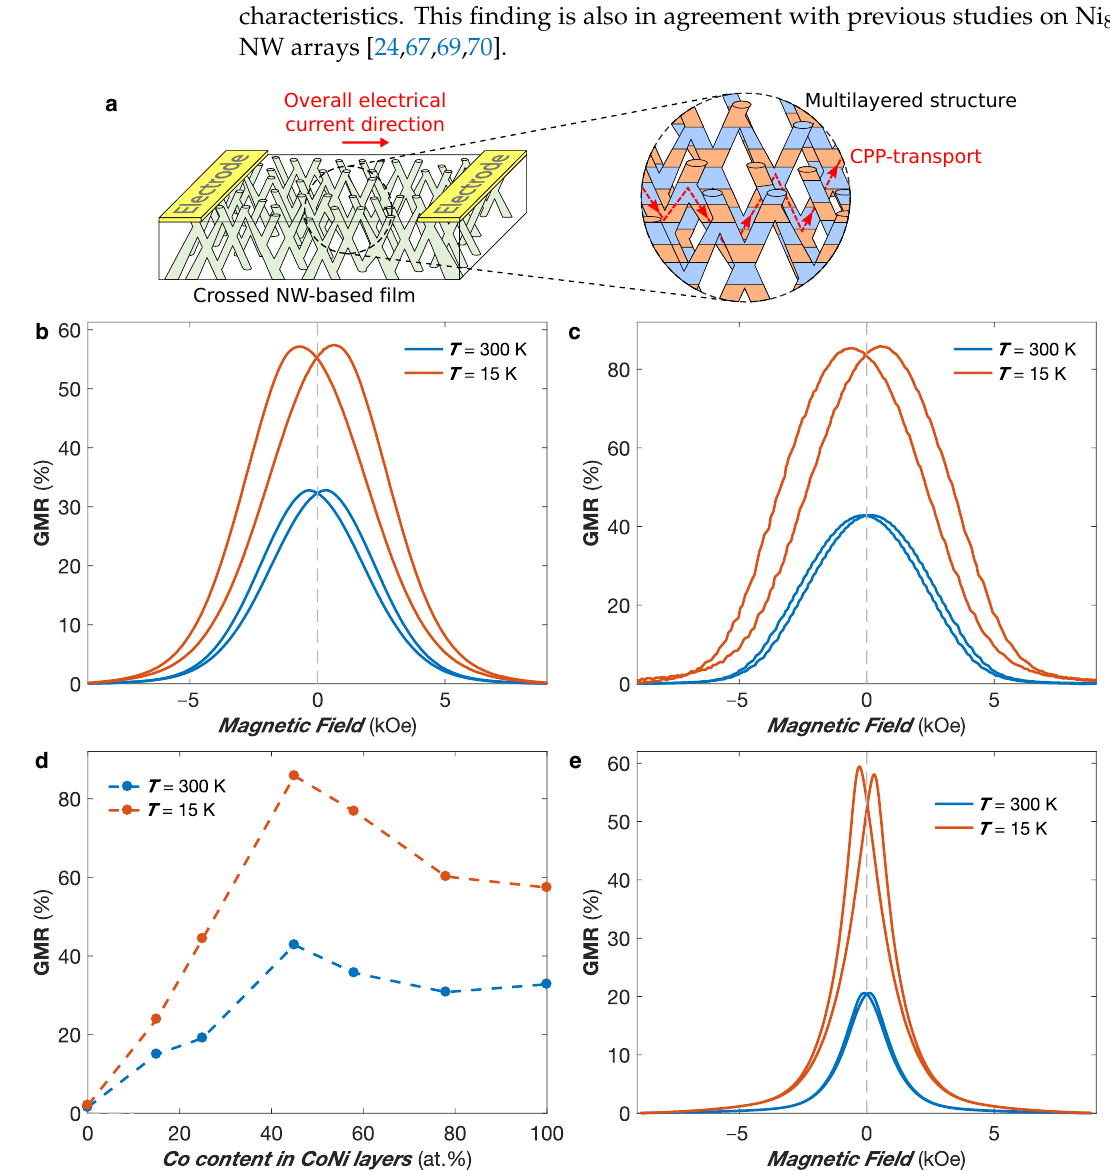
Figure 8. ( a ) Schematic of the giant magnetoresistance measurement in multilayered nanowire-based films, where the electrical transport takes place globally in the plane of the film while the architecture based on crossed nanowires ensures a CPP-type transport. ( b , c ) Giant magnetoresistance curves obtained at T = 300 K (blue curves) and T = 15 K (red curves) with the magnetic field applied in the plane of interconnected (b) Co/Cu and (c) Co 50 Ni 50 /Cu nanowire networks with 80 nm in diameter and ∼ 3% in packing fraction. ( d ) Giant magnetoresistance ratio obtained for interconnected Co x Ni 1 − x /Cu multilayered nanowire networks with 80 nm in diameter and ∼ 3% as for 0 ≤ x ≤ 1 at T = 300 K (in blue) and T = 15 K (in red). The dashed lines are guides for the eyes. ( e ) Giant magnetoresistance curves obtained at T = 300 K (blue curves) and T = 15 K (red curves) with the magnetic field applied in the plane of interconnected Ni 80 Fe 20 /Cu nanowire networks with 80 nm in diameter and ∼ 3% in packing